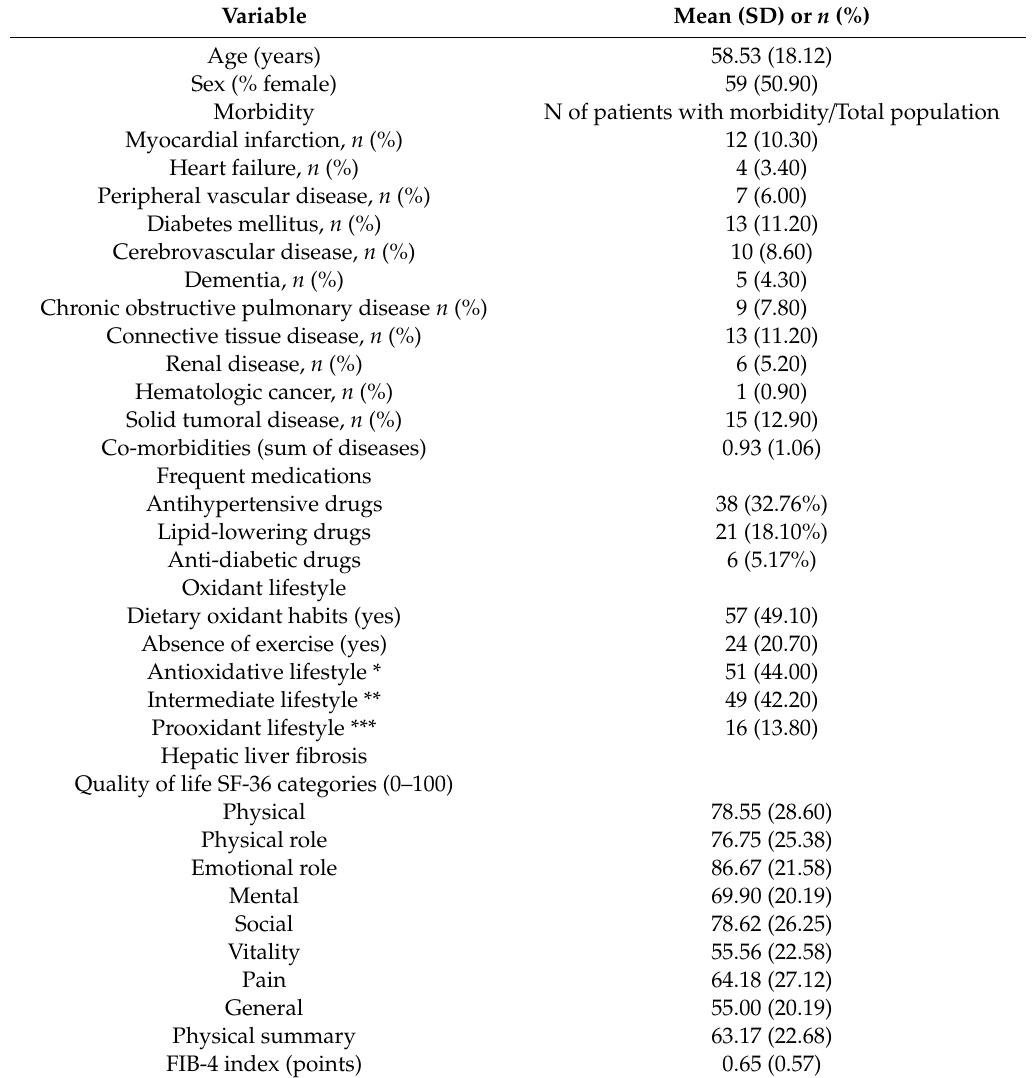
Table 1. Population characteristics ( n =